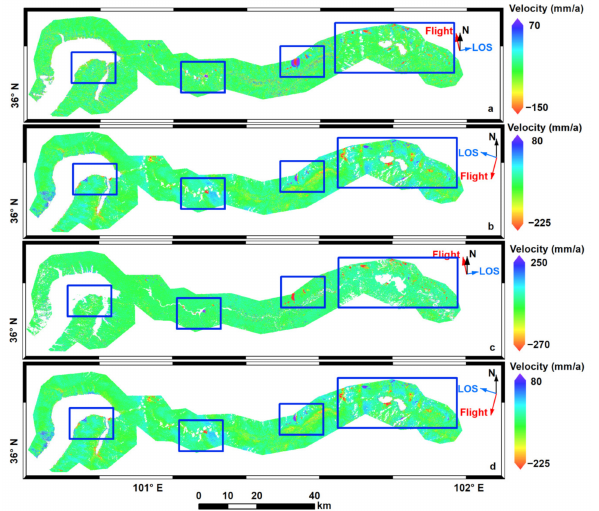
Figure 5. Annual interferometric synthetic aperture radar (InSAR) deformation rate maps of the study area. ( a ) Displacement rate in the ascending line-of-sight (LOS) direction acquired using the STACKING technique; ( b ) displacement rate in the descending LOS direction acquired using the STACKING technique; ( c ) displacement rate in the ascending LOS direction acquired using interferometric point target analysis (IPTA); and ( d ) displacement rate in the descending LOS direction acquired using